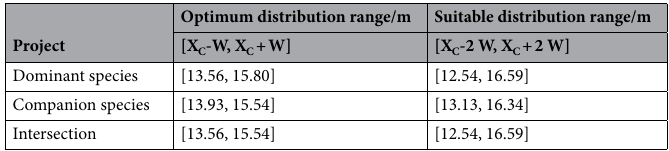
Table 2. Gaussian statistics of the elevation range of distuributed C. cinerascens.